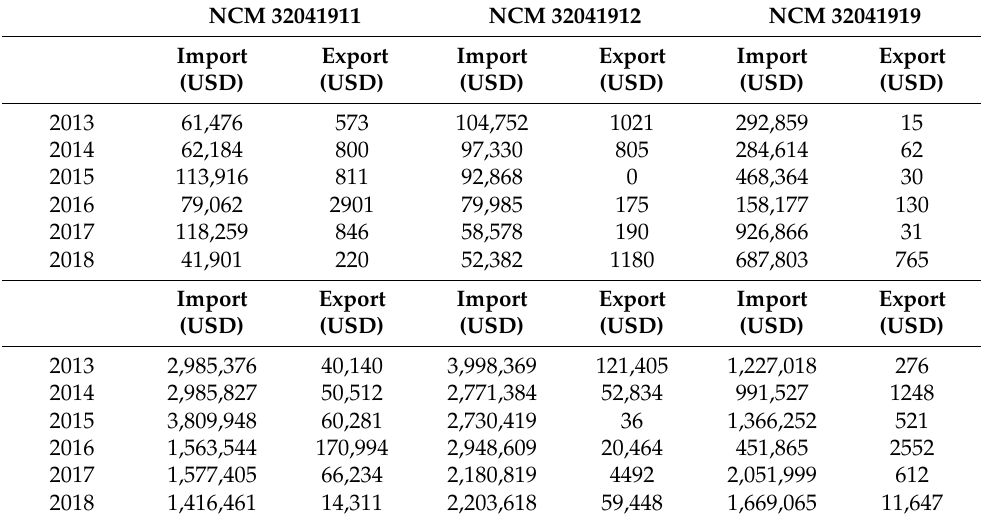
Table 2. Brazilian trade data related to the import and export of carotenoids, preparations containing β -carotene and other carotenoid-based preparations from 2013 to 2018.